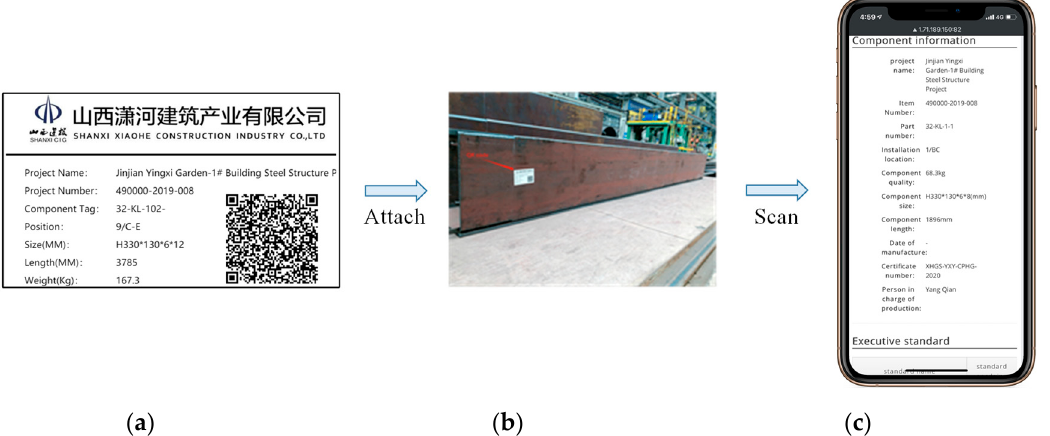
Figure 10. Quick response (QR) code: ( a ) QR code exported in this platform; ( b ) QR code attached to the component; ( c ) the interface after scanning the QR code.